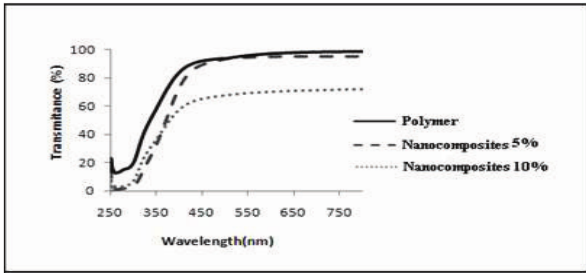
Figure 4. Uv-vis spectra of PA 3 , PA-nanocomposite films 3a and 3b